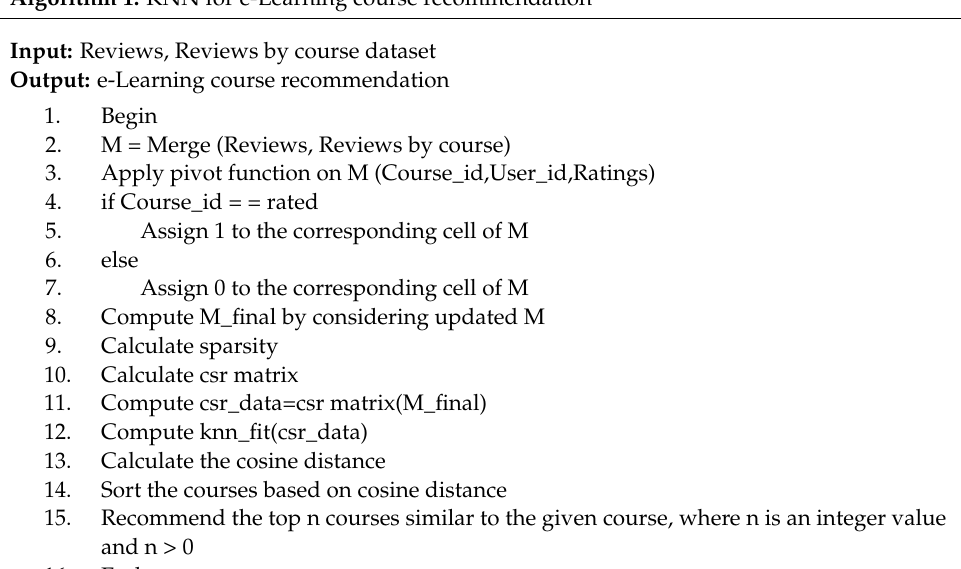
Algorithm 1: KNN for e-Learning course